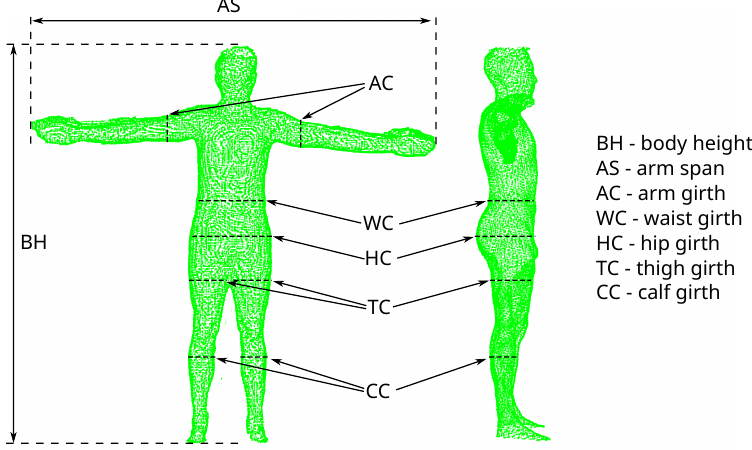
Figure 1. A 3D scan with marked places of estimation of parameters.